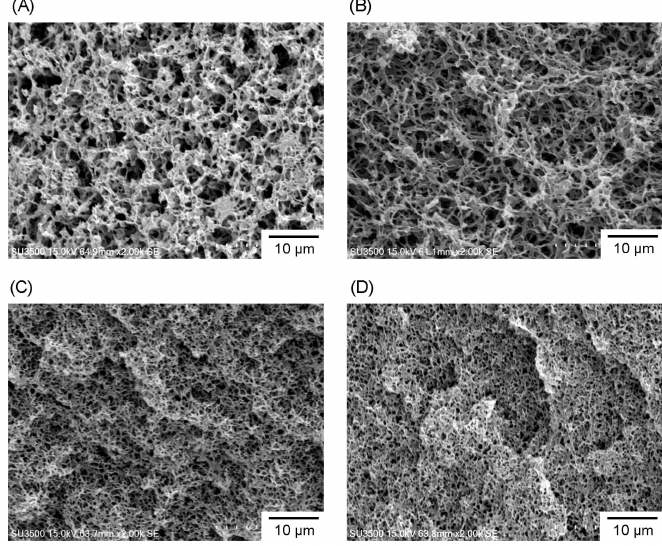
Figure 2. SEM images of P3HB3HH 6 monoliths prepared from different polymer concentration